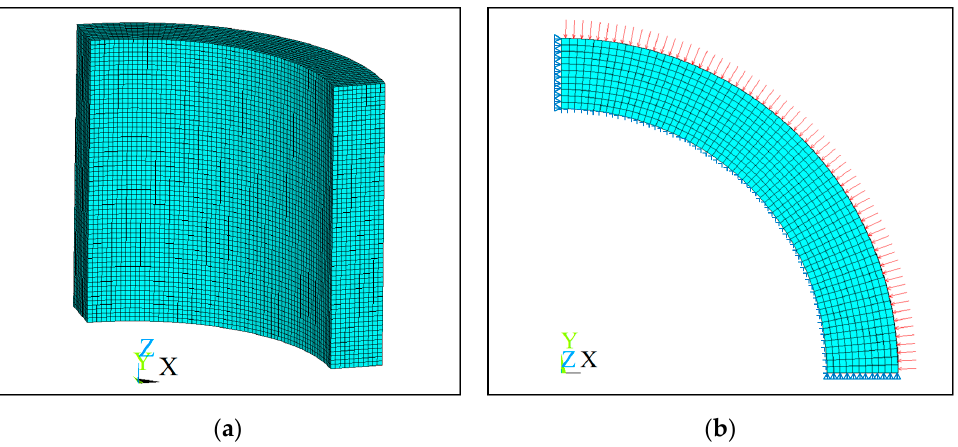
Figure 2. ( a ) Mesh division of the shaft lining model; ( b ) boundary conditions of the shaft lining model.